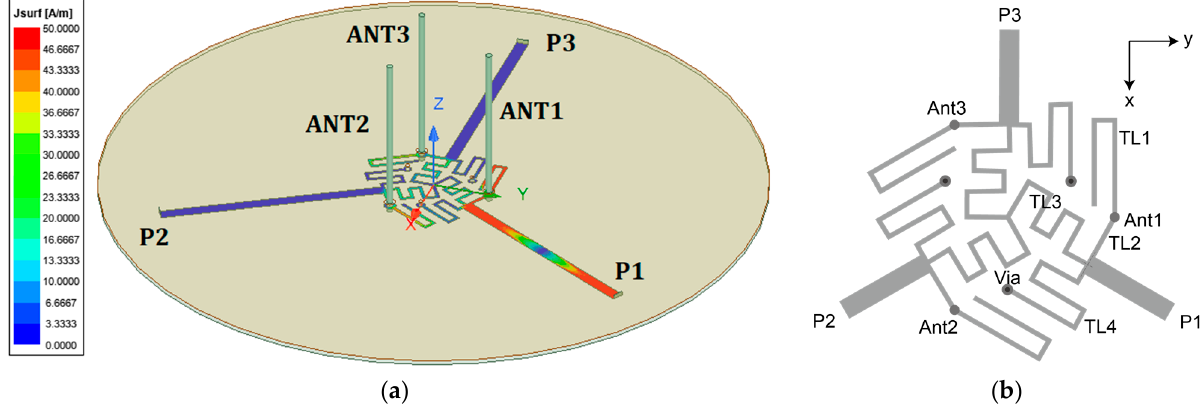
Figure 9. The even and odd admi tt ances at reference plane t 3 .